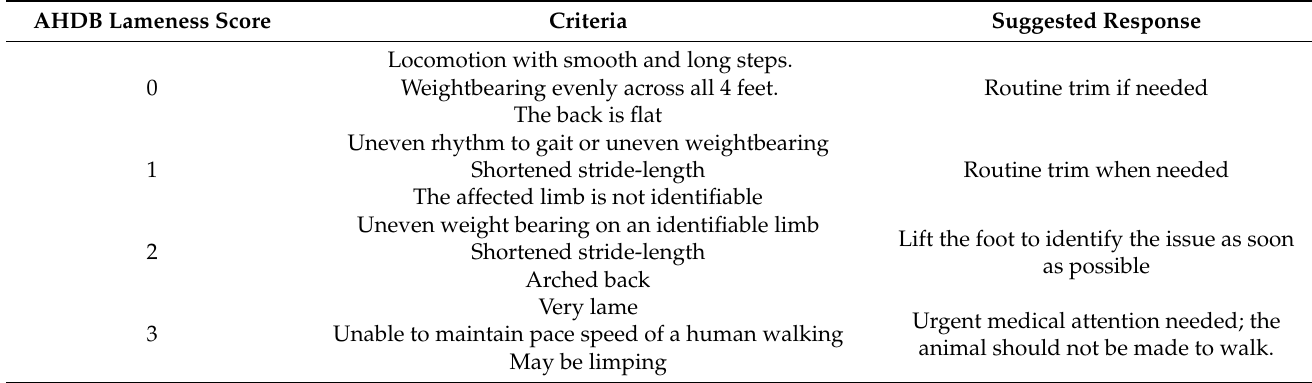
Table 2. The AHDB mobility scoring criteria and suggested response for each grade, 0 – 3. Grades of 2 and 3 are classified as lame cows.